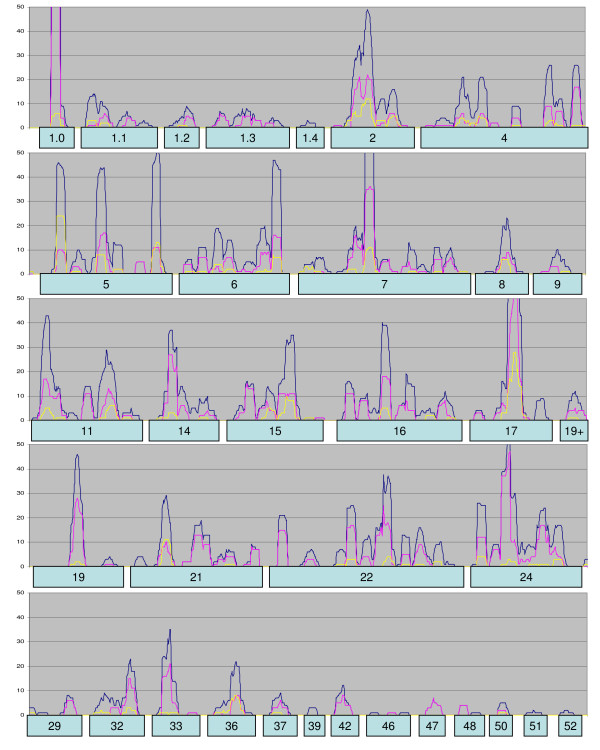
Marker clustering in linkage map. Smoothed density of markers within a 10 cM moving window on the 'Kanota' × 'Ogle' framework linkage map. The dark blue line shows the overall density of markers including DArT markers and those mapped prior to 2003. Magenta shows the distribution of DArT markers alone. The yellow line shows the density of AFLP markers mapped prior to 2003.